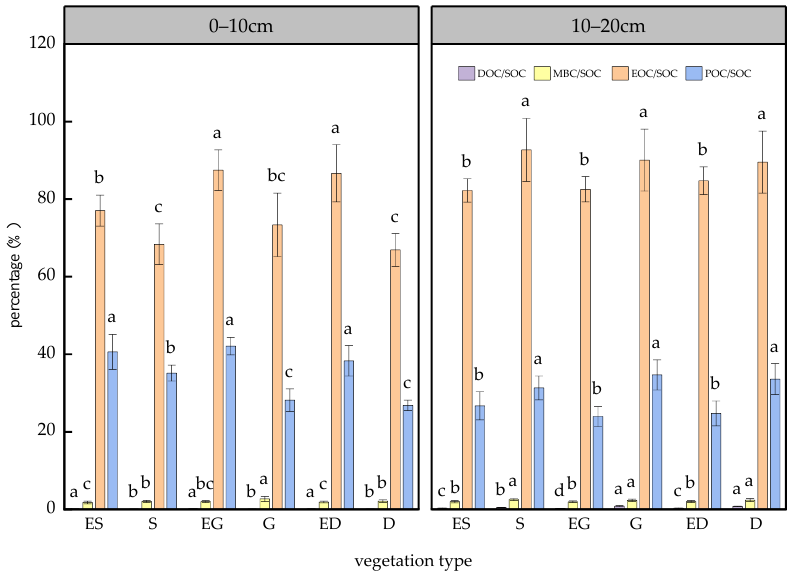
Figure 2. Ratios of SOC fractions to SOC in different vegetation types. Different lowercase letters indicate significant differences between different forest types ( p < 0.05).